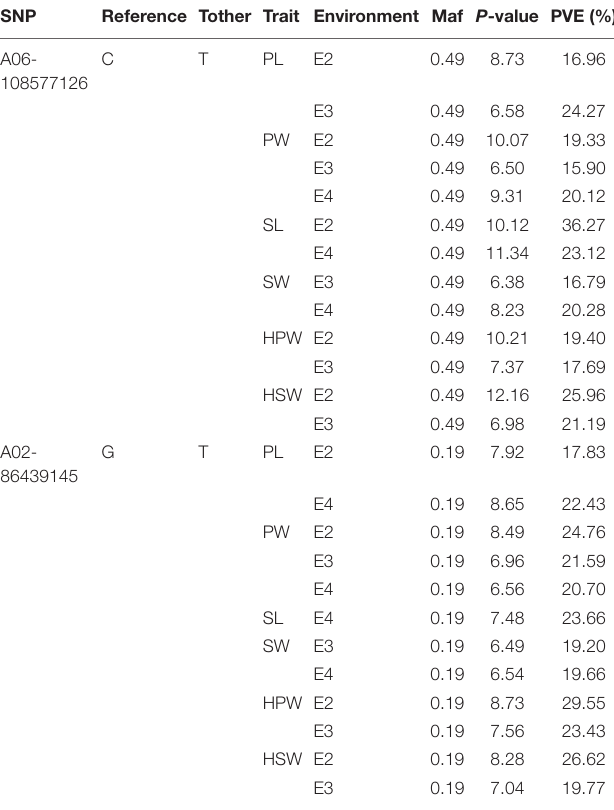
TABLE 3 | The repeated detected major association loci ( P < 4.73 × 10 − 7 ). SNP Reference Tother Trait Environment Maf P -value PVE